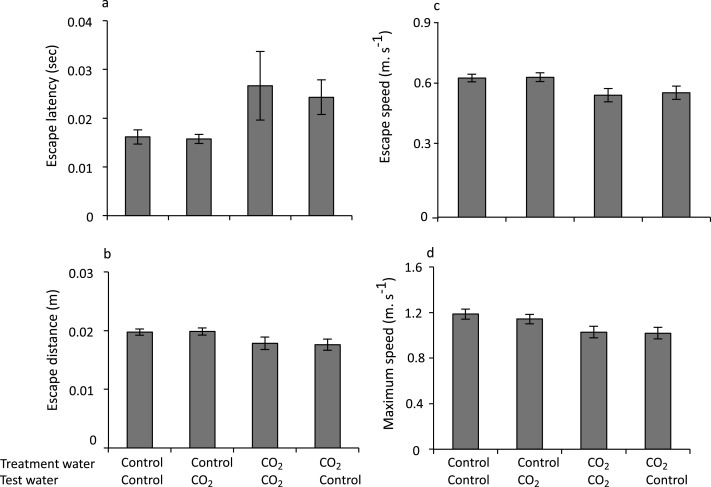
The effect of rearing treatment (control or high CO2) and test water used in the experimental trial (control or high CO2) on the escape performance of larval P. amboinensis.Variables displayed are: (A) latency, (B) distance, (C) mean speed, and (D) maximum speed. Errors are standard errors. N = 26, 28, 26, 28 for control - control, control - high CO2, high CO2 - high CO2 and high CO2 - control, respectively.